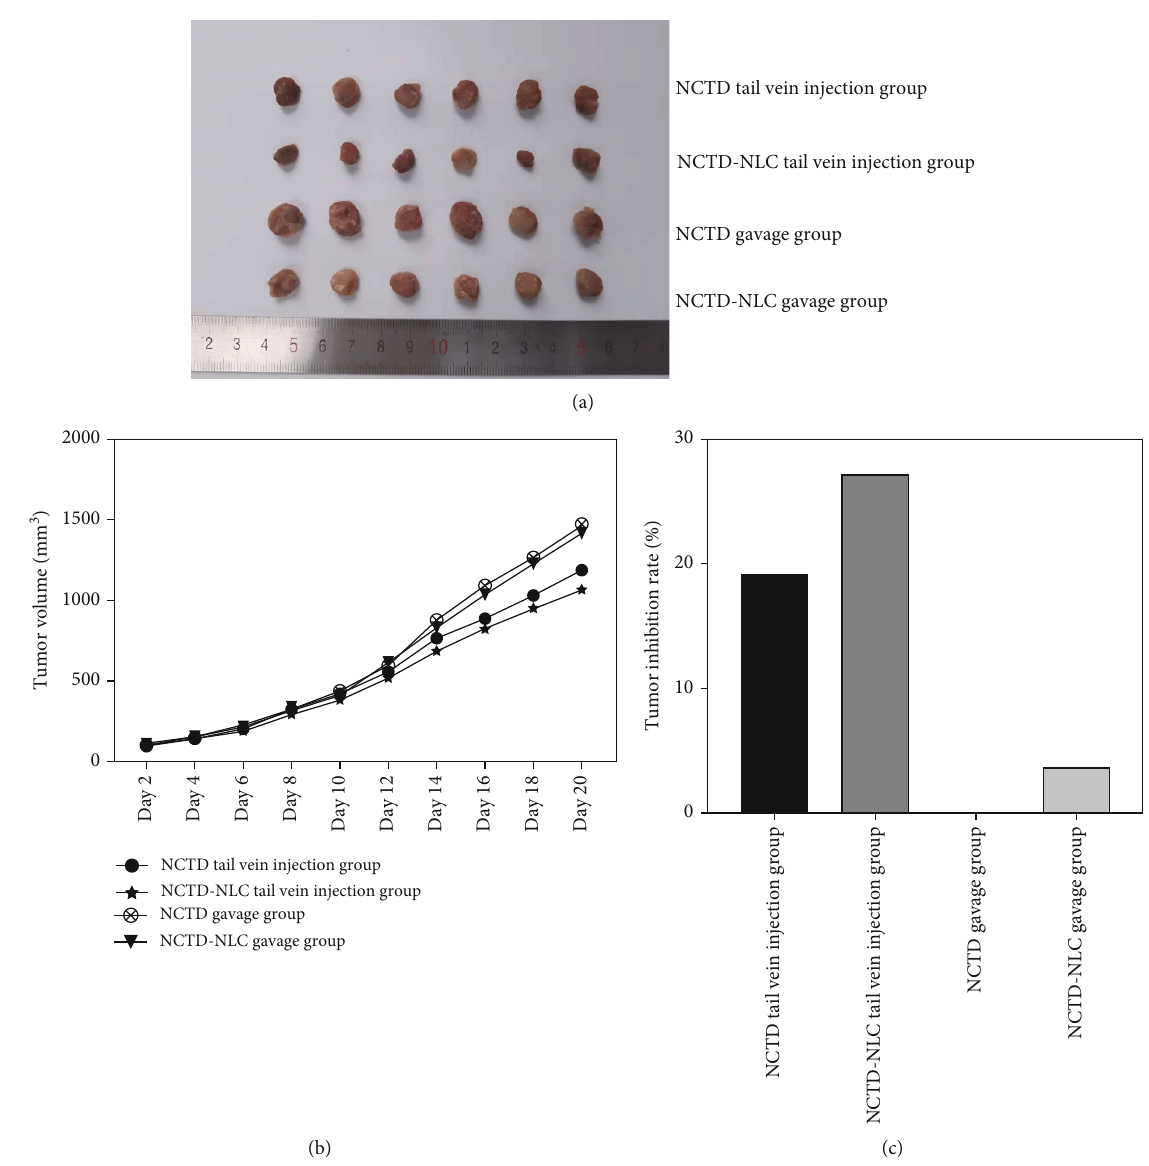
Figure 4: Results of tumor formation in nude mice after treatment in each group: (a) tumors isolated from each group of mice; (b) graph of tumor volume of nude mice in each group; (c) statistical results of tumor inhibition rate in each